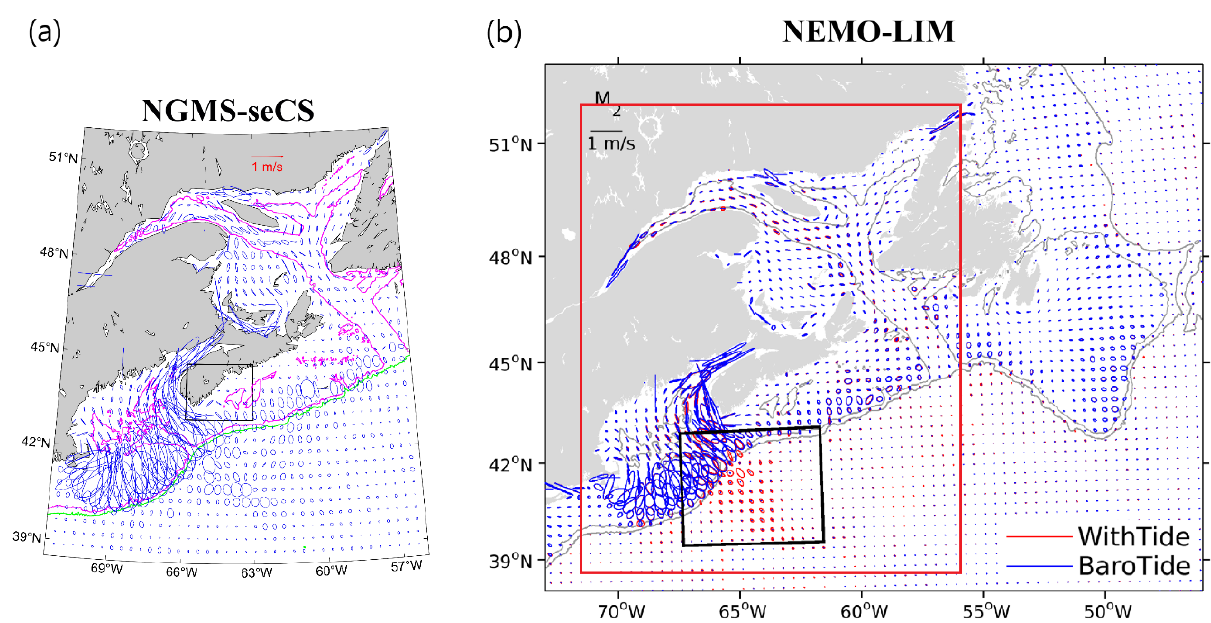
Figure 4. ( a ) Ellipses of ( a ) surface M 2 tidal currents (blue ellipses) for June 2018 simulated in case CR and ( b ) the counterparts taken from Wang et al. [9] (red ellipses represent baroclinic M 2 tides and blue ellipses represent barotropic M 2 tides). For clarity, the M 2 tidal current ellipses in ( a ) are plotted at every 14th grid point of submodel L2. The ellipses inside (outside) the black box in ( a ) are based on results of submodel L3 (submodel L2). The magenta and green contours represent the 200-m and 1000-m isobaths, respectively. The red box in ( b ) indicates the L2 domain of the NGMS-seCS.